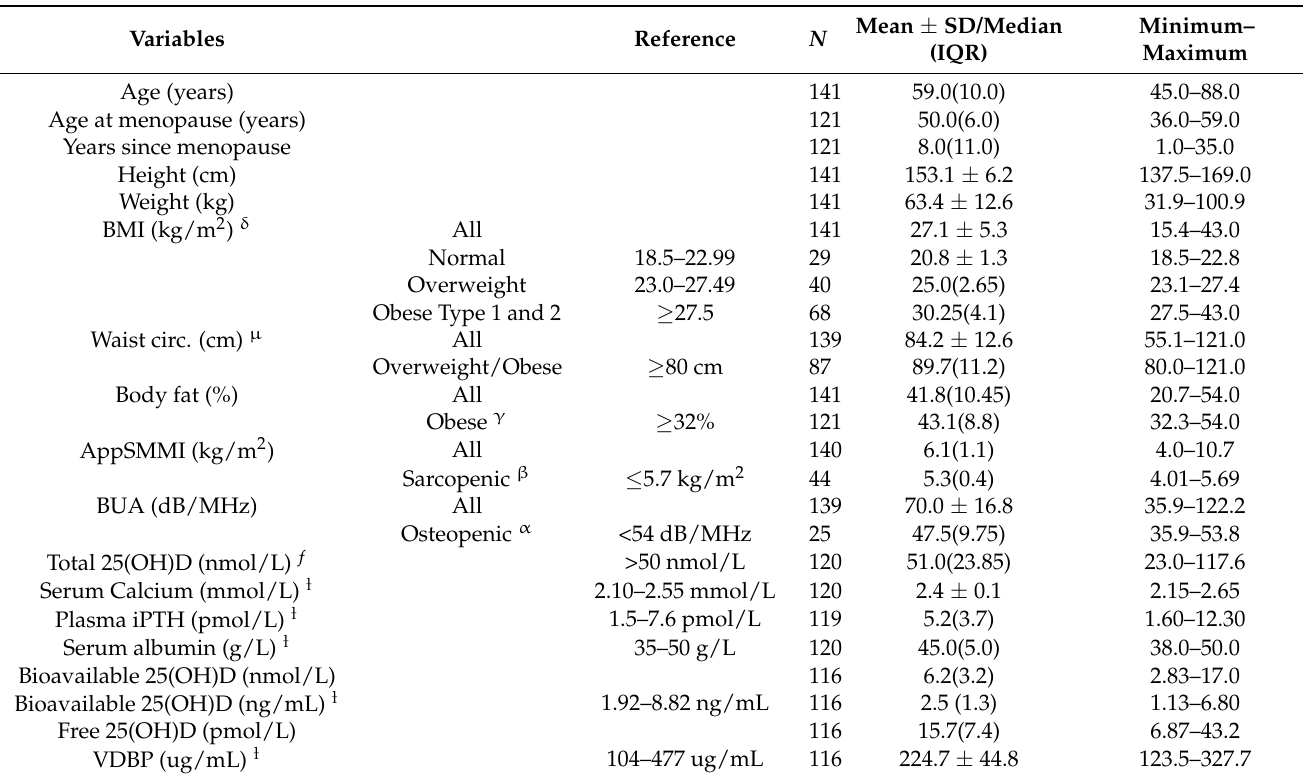
Table 1. Characteristics (Malay, n = 51; Chinese, n = 42; Indian, n = 48) and blood parameters (Malay, n = 49; Chinese, n = 35; Indian, n = 36) of